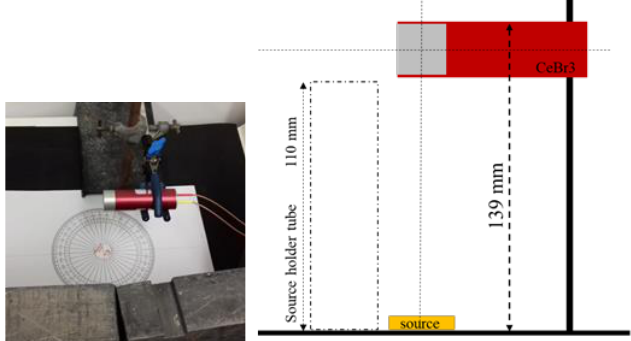
Figure 6 – Experimental setup applied to study the detector gamma-ray spectral performance. T ABLE II G AMMA - RAY ENERGIES AND EMISSION PROBABILITIES FOR THE RADIONUCLIDES USED IN THE EXPERIMENT [32]